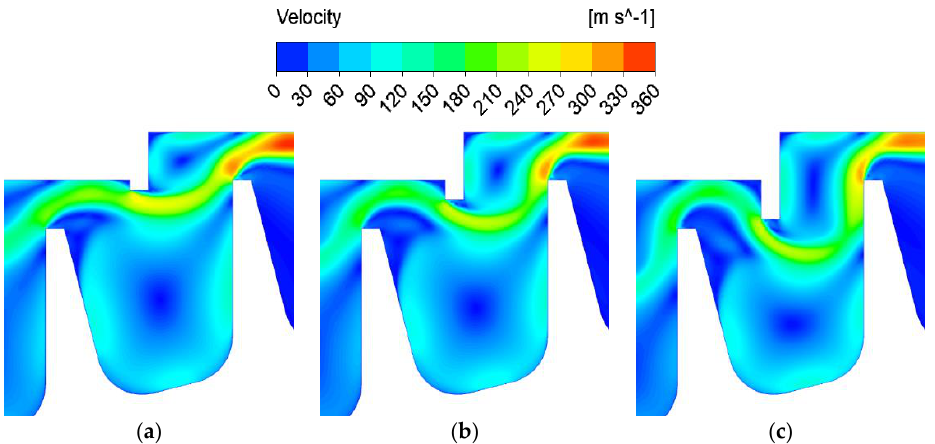
Figure 12. Velocity contour plots for various t/K (PR = 2.5, S/H = 1.0, β = 90°). ( a ) t/K = 0.05. ( b ) t/K = 0.1. ( c ) t/K = 0.2. ( b ) t/K = 0.1. ( c ) t/K =